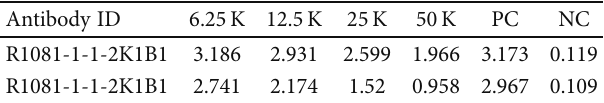
Table 3: AcrB antibody titer.